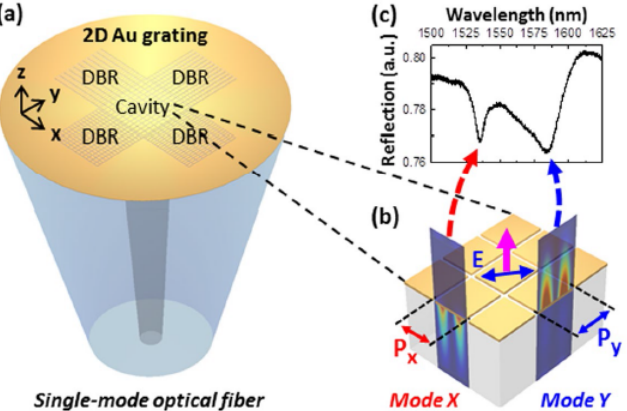
Figure 30. ( a ) Schematic representation of the lab-on-fiber multiparameter nanoprobe with a plasmonic crystal cavity on the fiber end-face; ( b ) two spatially separated RA-SPP resonance modes excited in the plasmonic crystal cavity; ( c ) The reflection spectrum from the nanoprobe with two resonances near 1550 nm. Reprinted with permission of [95].